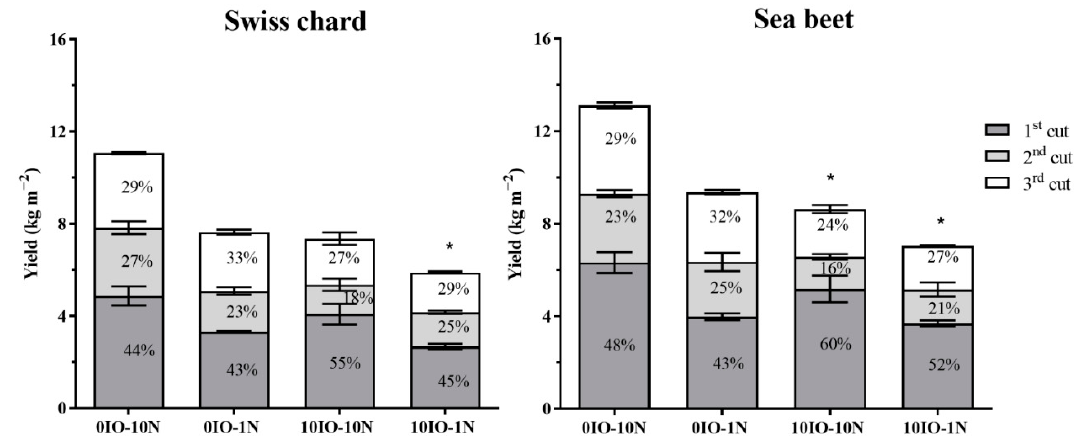
Figure 1. Crop yield (fresh leaves) of Swiss chard (left) and sea beet (right) grown hydroponically under greenhouse with different concentrations of the sea salt Instant Ocean (IO; 0 and 10 g L − 1 ) and nitrogen (1 and 10 N-NO 3 mM) in the nutrient solution (see Table 2 for abbreviations). Plants were harvested trice during the experiment; the values inside the bar are the percent contribution of each harvest to the total crop yield. Mean values ( ± s.e.; n = 3) keyed by the asterisk (*) are statistically different from the control (0IO-10N), according to the t